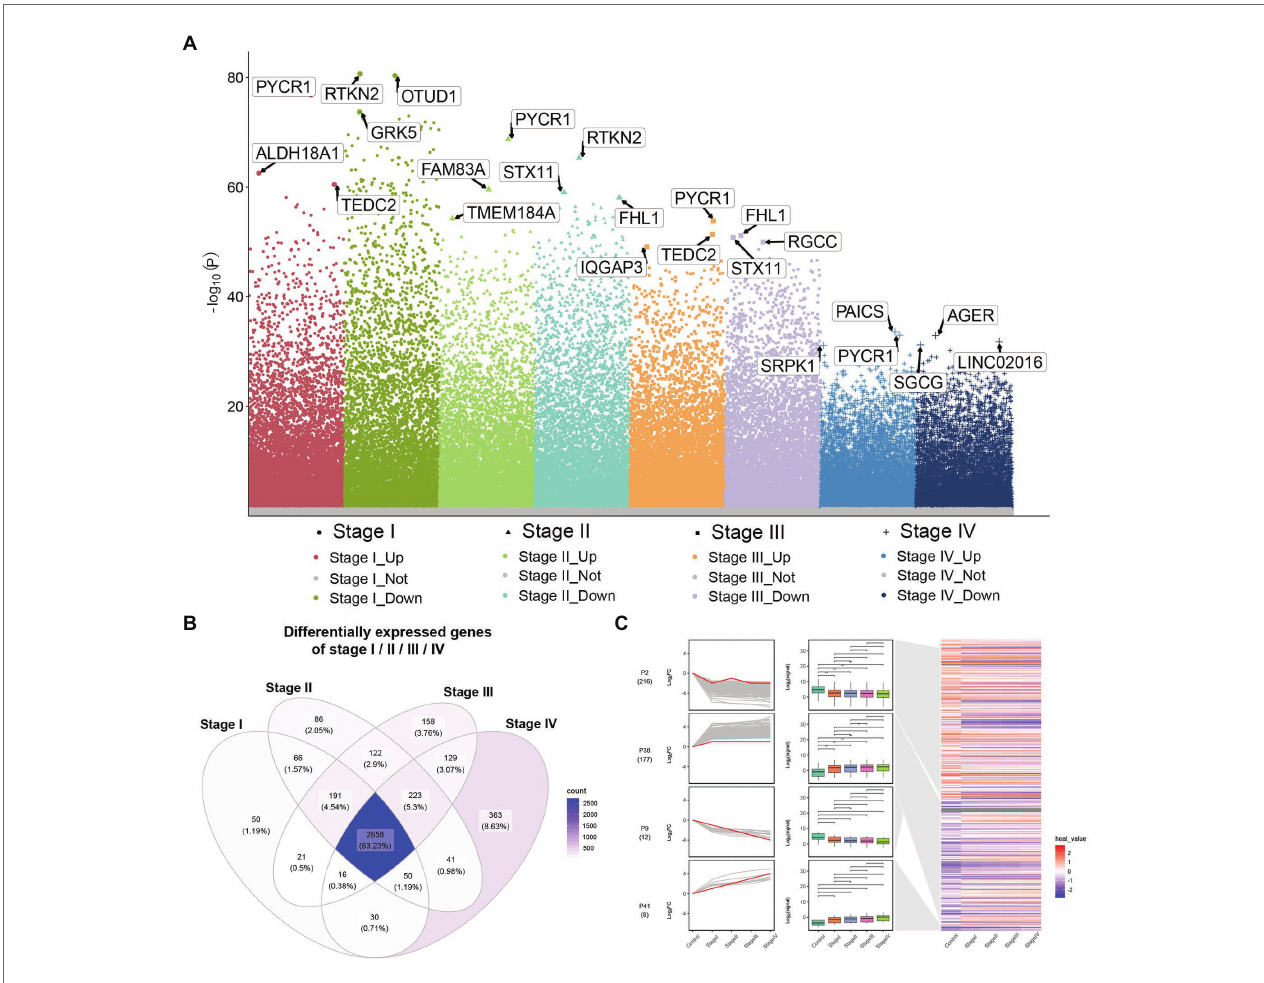
FIGURE 2 | Differential expression gene analysis and short time-series expression miner (STEM) analysis. (A) Manhattan plot showed differentially expressed genes (DEGs) in different stage of lung adenocarcinoma (LUAD). Genes with significant differences are highlighted. (B) Common DEGs in LUAD stage I–IV. (C) STEM results. Line plots (left panels) and box plots (right panels) are used to show fold changes (log2 scale) and absolute expression levels (log2 scale), respectively. In each line plot, one representative gene is highlighted in